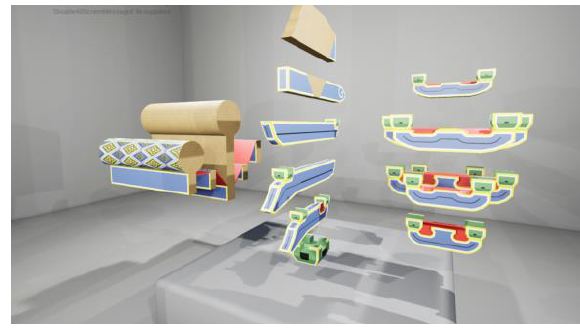
Figure 22. Disassembly and installation of the bucket arch